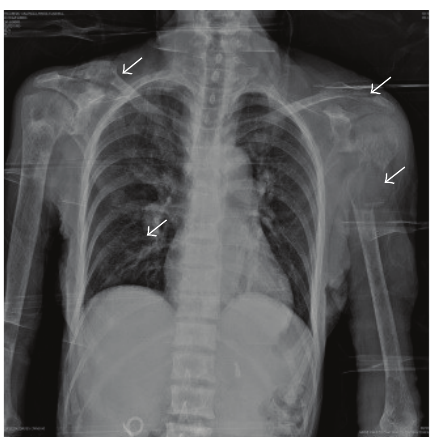
Figure 1: Chest X-ray with severe widespread cortical bone loss, cysts, and brown tumors (arrows) in ribs, distal third of the clavicle, and humerus for severe cystic fibrous osteitis due to prolonged PHPT.